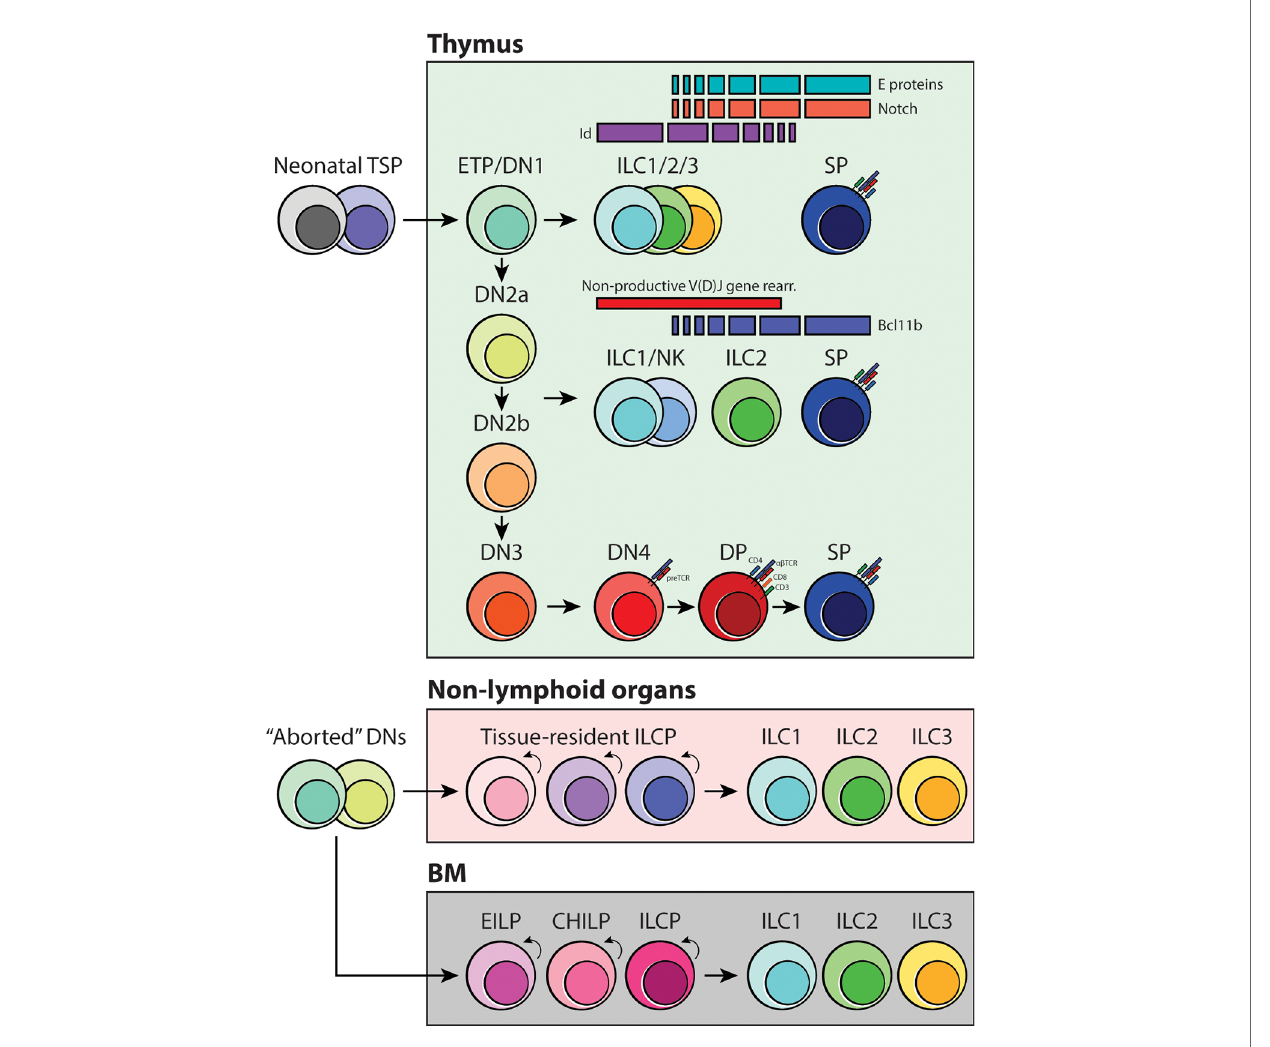
FIGURE 4 | Schematic of ILC development in coordination with thymocyte speci fi cation and maturation. As early T-cell progenitors are known to be multipotent, we propose that the branchpoint in which ILC differentiation occurs is at the DN1/ETP and DN2-DN3 transition stage. Depending on the status of the TCR loci, strength of Notch signaling and activities of E-Id proteins and Bcl11b, developing thymocytes may acquire innate-like properties and give rise to one of three ILC subsets. Furthermore, we suggest that tissue-resident ILC progenitors, including the BM, originate from failed T-cell development and locally maintain the mature ILC